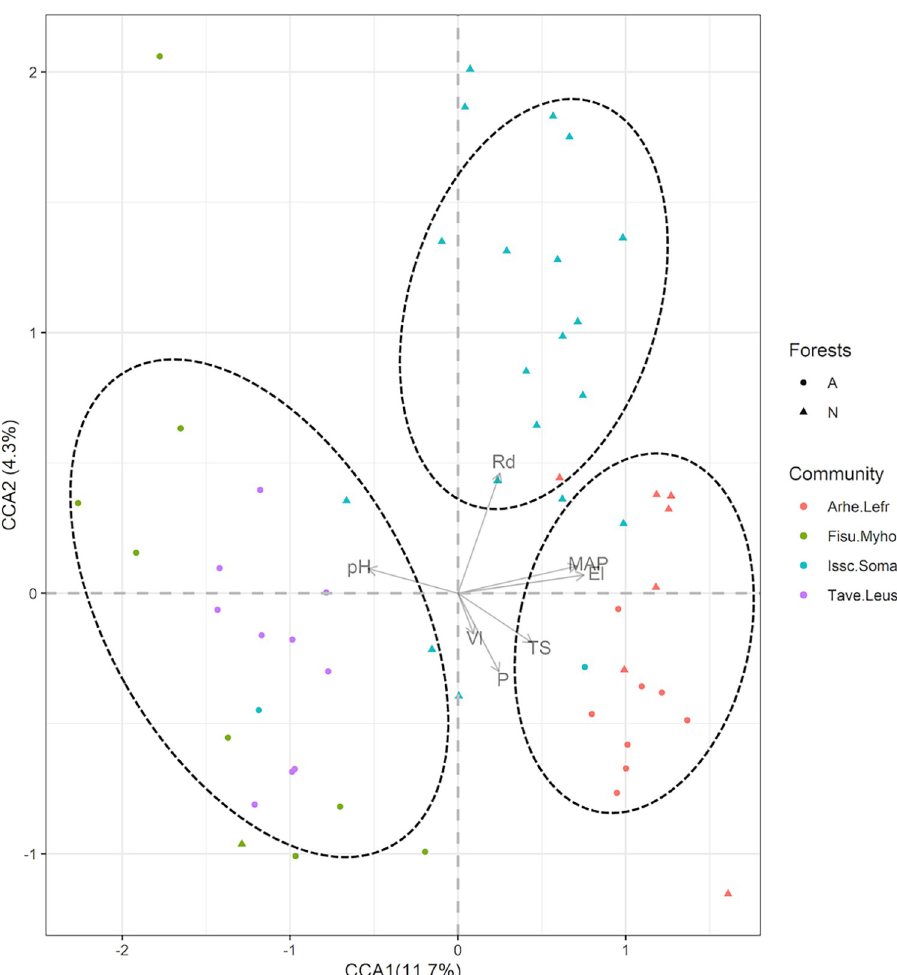
Fig 4. Canonical correspondence analysis diagram displaying the ordination of community types represented and their correlation with environmental and disturbance variables, indicating abundance relationships in sub- tropical East Usambara montane forest of Eastern Arc mountains. Communities: Tave.Leus = Tabernaemontana ventricosa- Leptonychia usambarensis , Arhe.Lefr = Artocarpus heterophyllus-Lecaniodiscus fraxinifolia , Fisu.Myho = Ficus sur- Myrianthus holstii and Isoberlinia schefflera- Sorindeia madagascariensis communities (S1 Appendix).